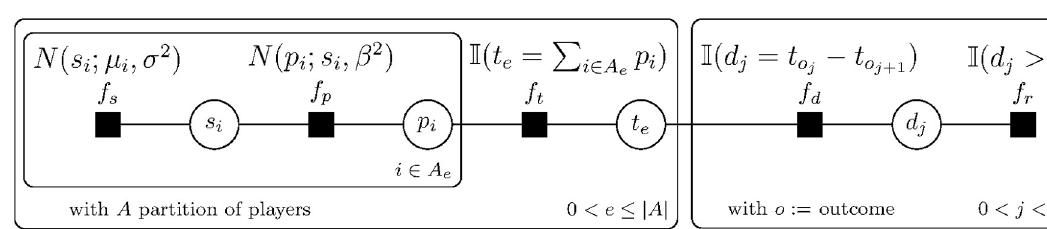
Fig 11. Bayes factor network of TrueSkill method.